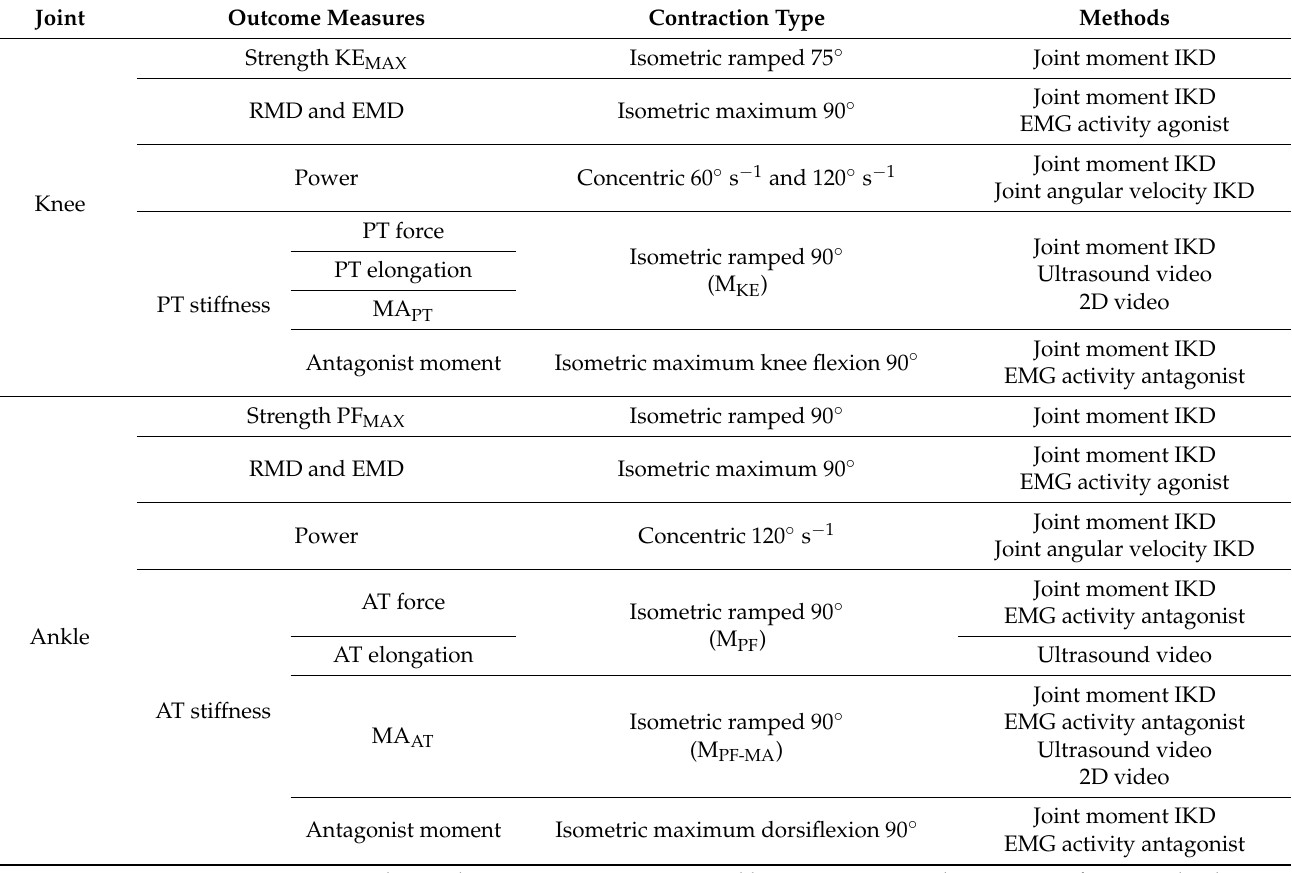
Table 1. Summary of the tests performed to measure strength, RMD, EMD, power and tendon